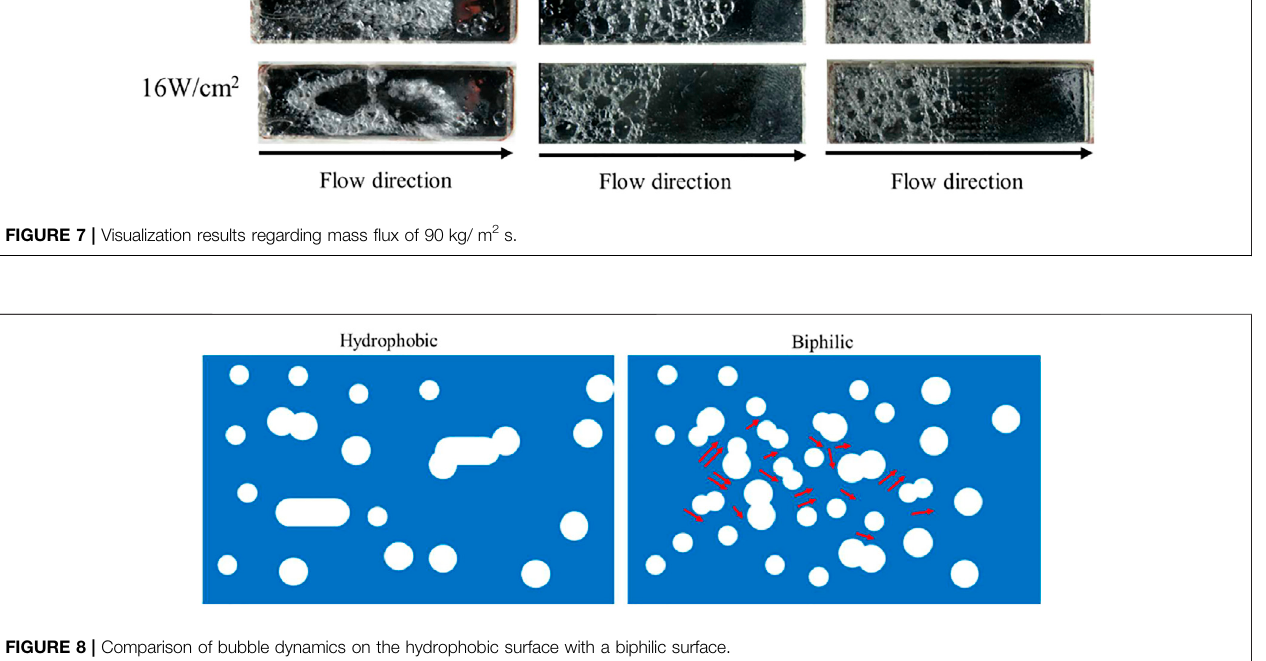
FIGURE 8 | Comparison of bubble dynamics on the hydrophobic surface with a biphilic surface.